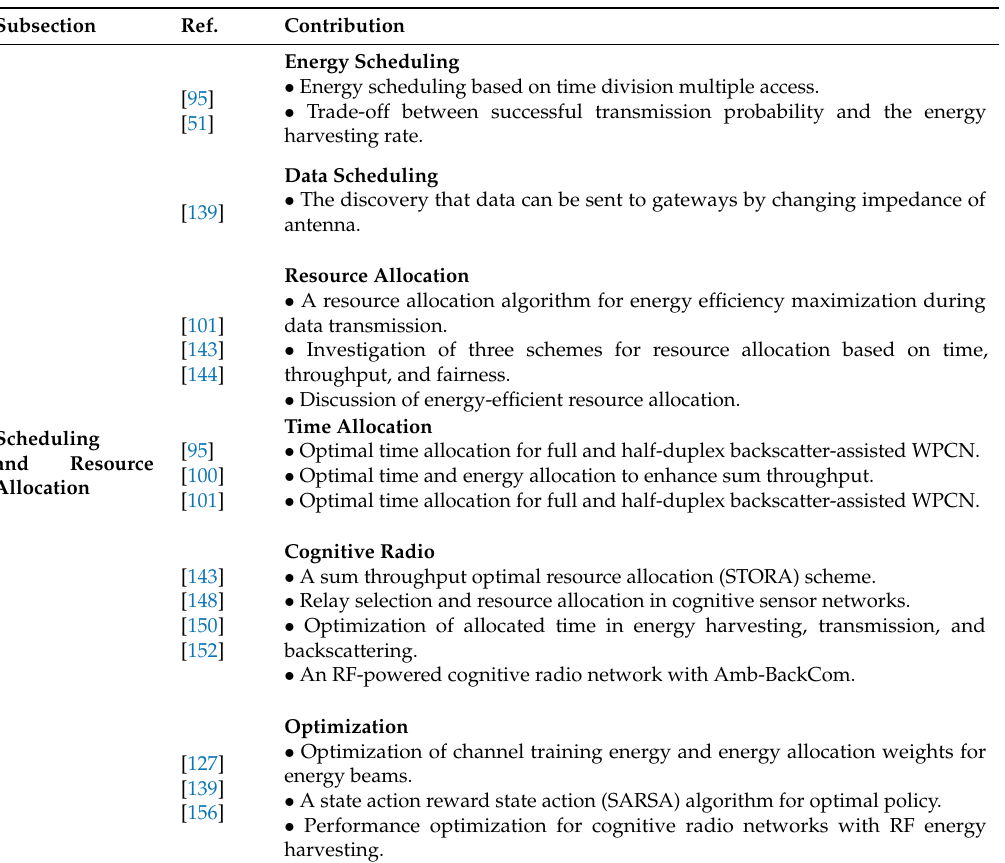
Table 10. Summary of BackCom scheduling and resource